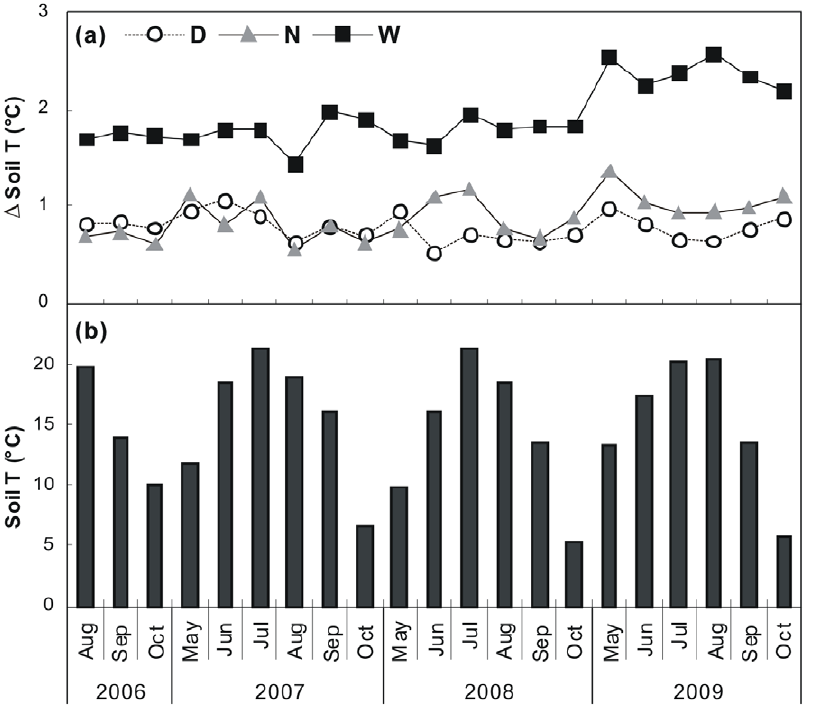
Figure 1. Monthly integrated values of (a) day (D), night (N), and whole-day (W) warming effects on soil temperature and (b) soil temperature in control plots. Soil temperature was measured at the depth of 10 cm.